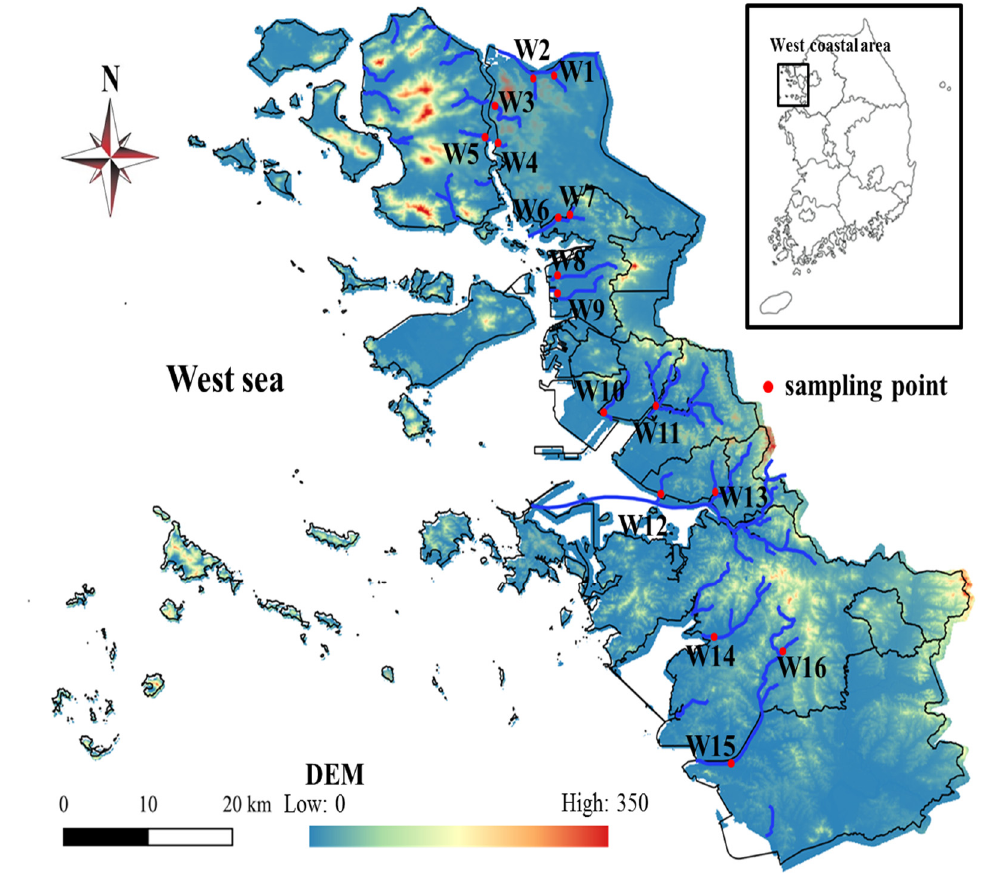
Figure 1. Digital elevation model (DEM) of the west coastal area and sampling site.